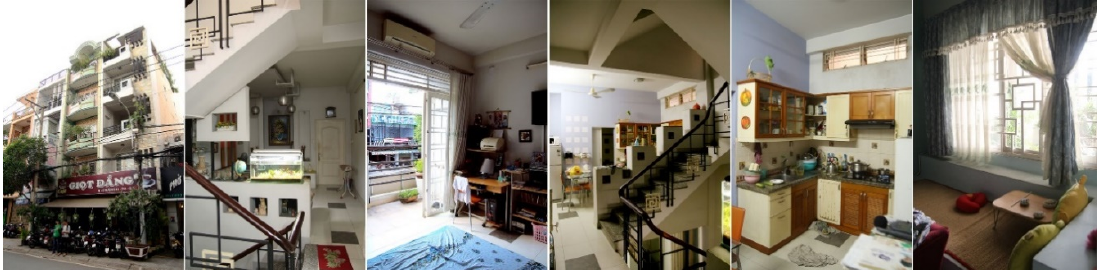
Figure 1. A sample of modern shophouse dwellings in Ho Chi Minh City (HCMC) (No 6, No 41 str, Dist 4, HCMC).